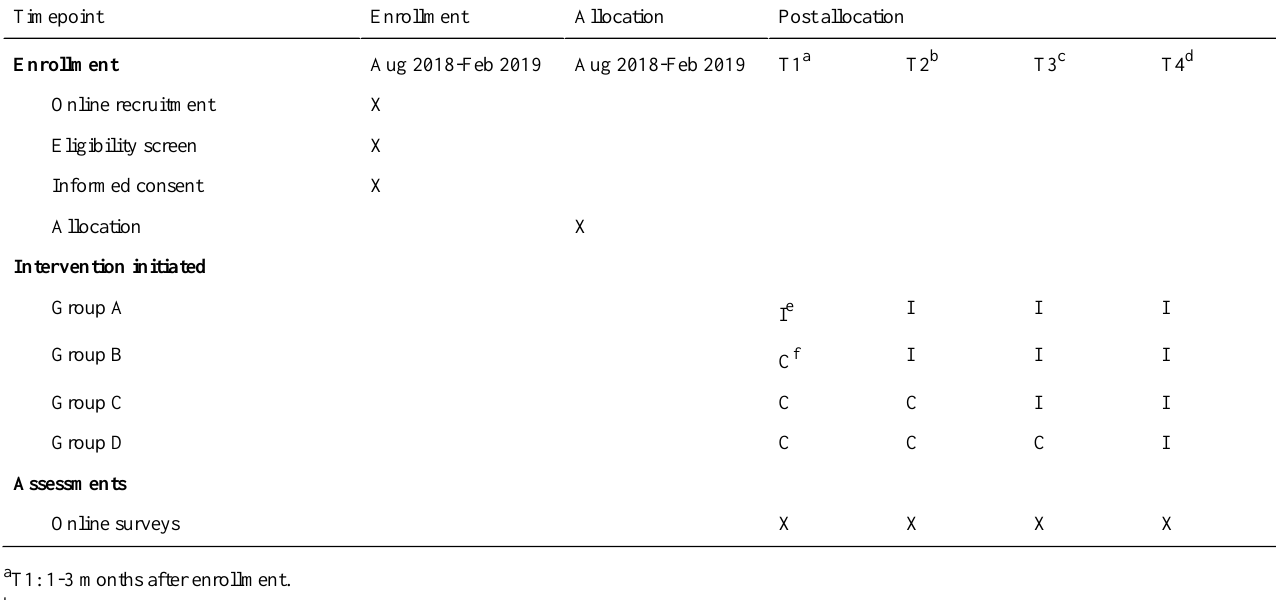
Table 1. Study schedule.